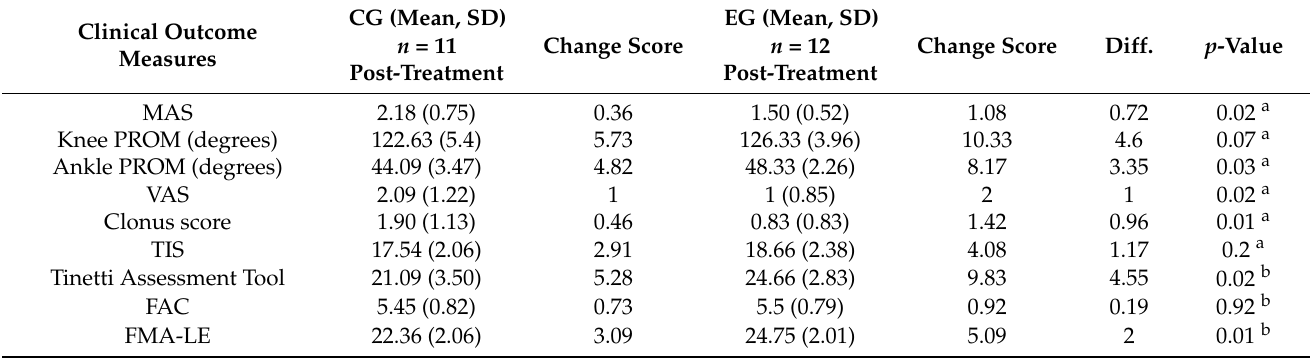
Table 3. Comparison of change score of clinical outcome measures between CG and EG